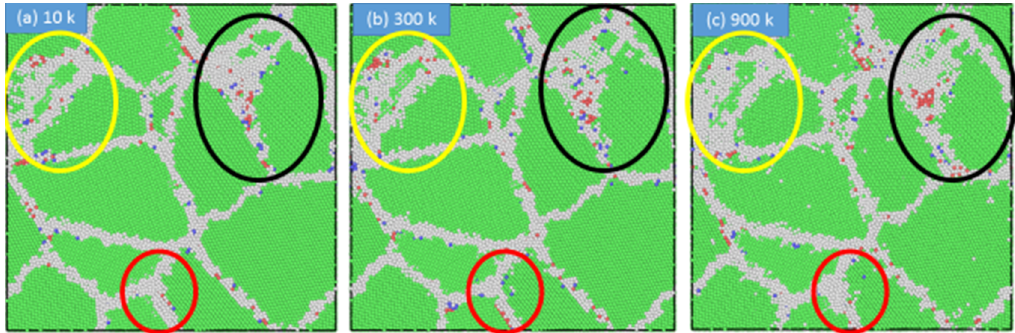
Figure 14. Snapshots showing the influence of temperature on the grain boundary thickness for the stainless steel sample with an average grain size of 3.6 nm: ( a ) 10 K, ( b ) 300 K, and ( c ) 900 K.